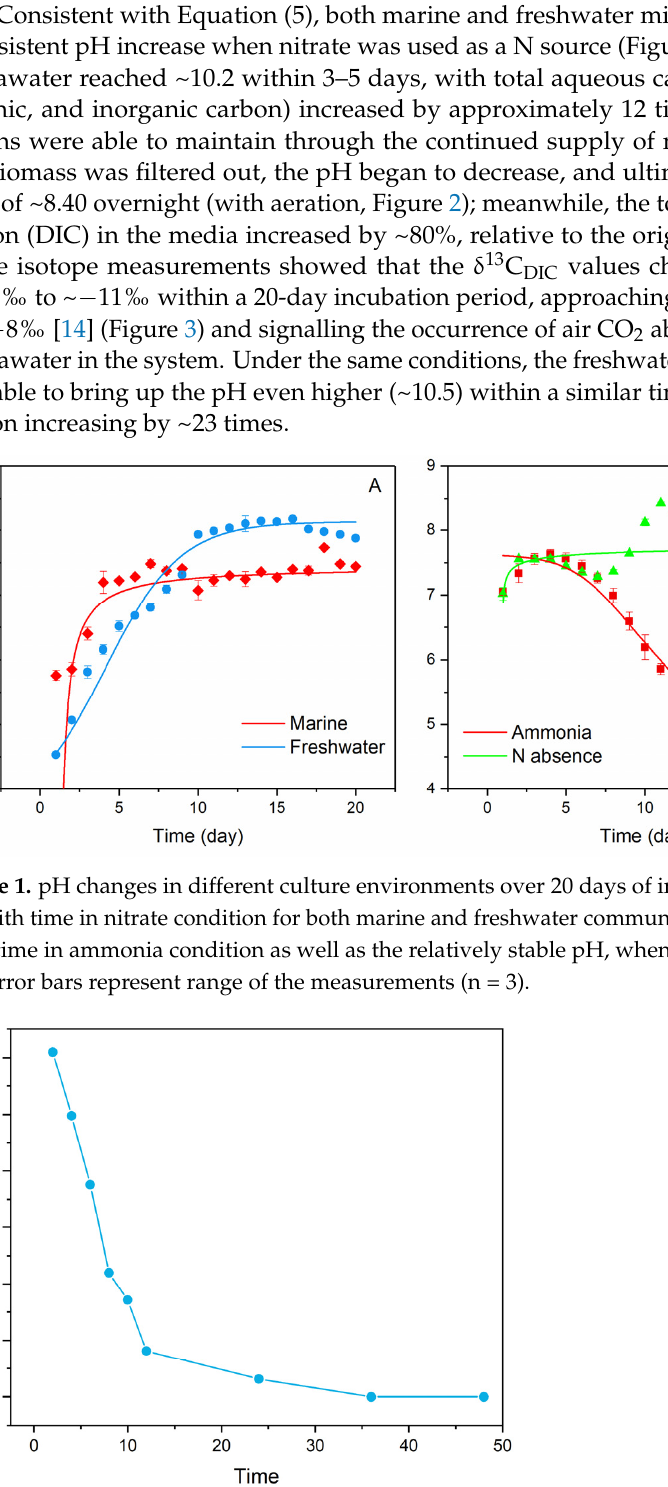
Figure 2. pH changes on time scale after continuous aeration.